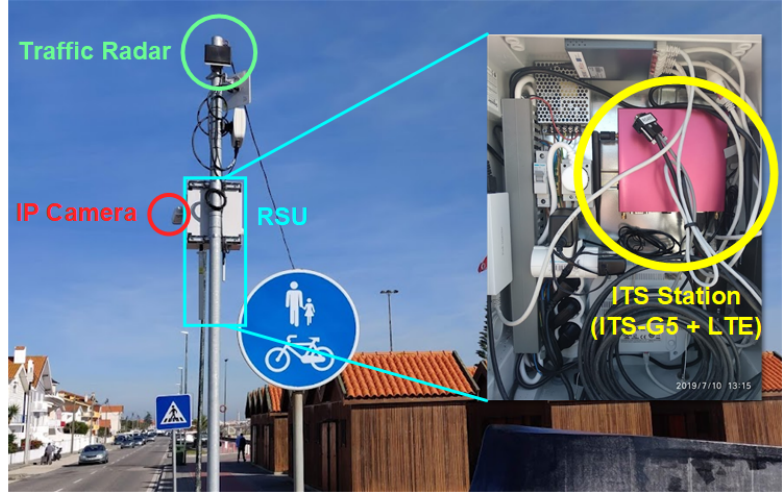
Figure 7. IT2S platform (ITS-G5 + LTE communications) and roadside sensors, i.e., traffic radar.